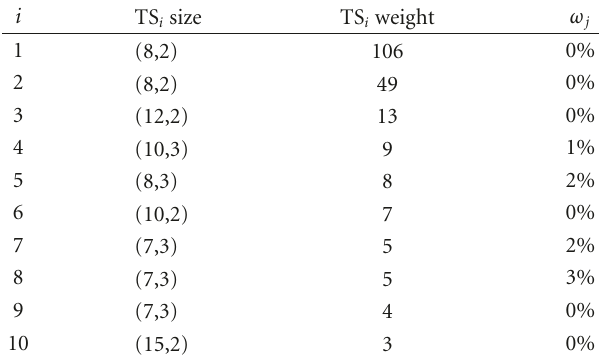
Table 3: Results after the learning phase of HE(1024,512) LDPC code.